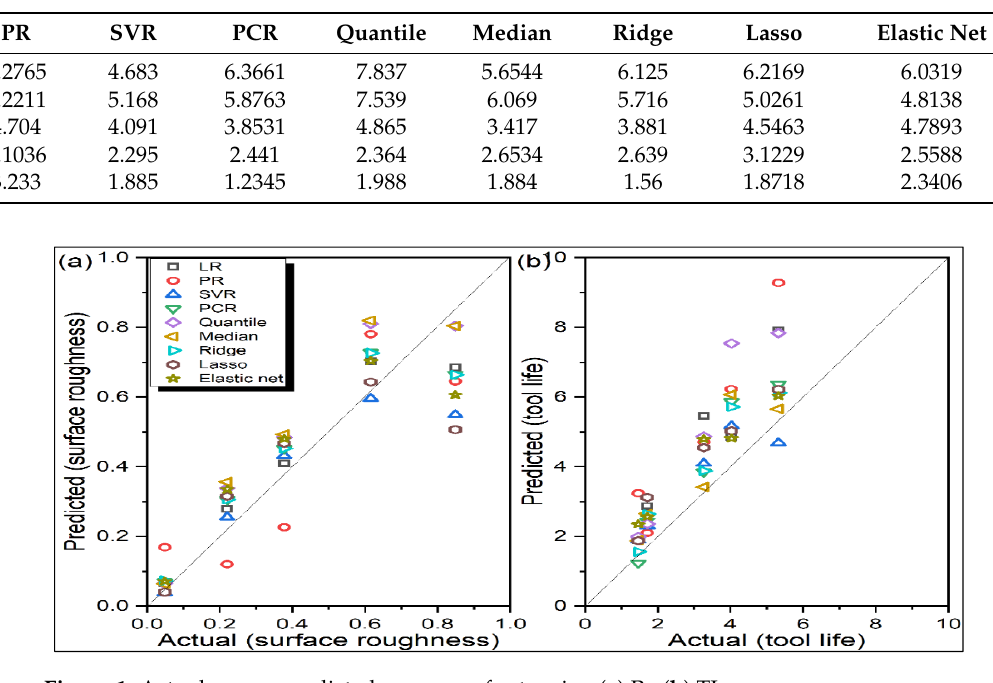
Figure 3. Prediction performance of various regression models for turning. Prediction errors in terms of (a) MAPE (b) RMSPE (c) RMSLE (d) RRSE